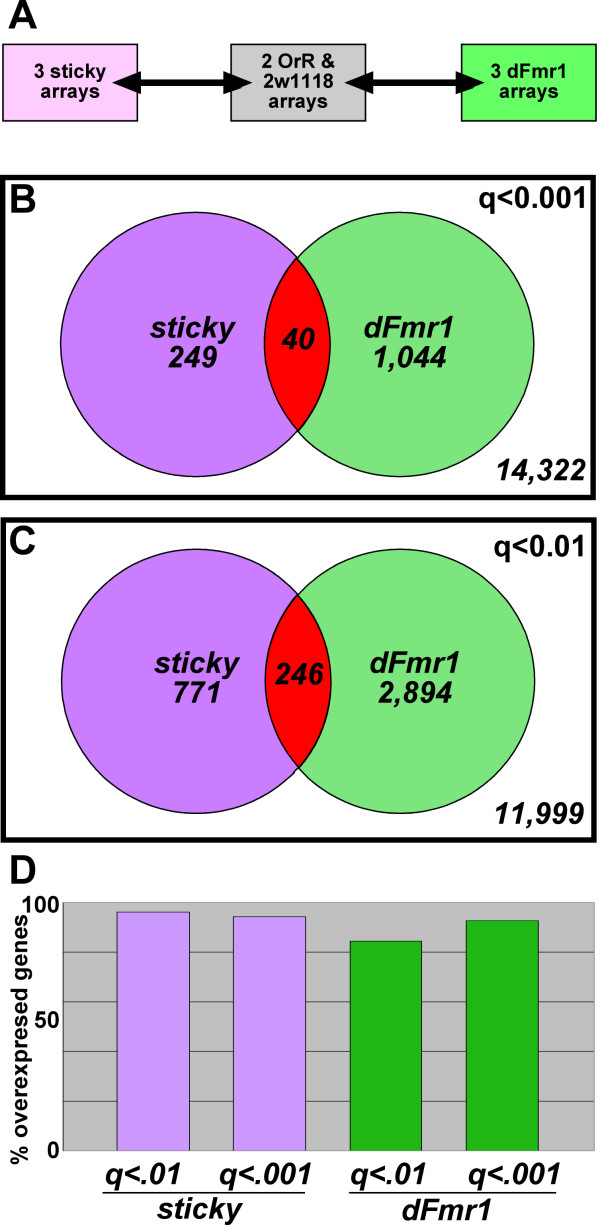
A common set of genes is misexpressed in sticky and dFmr1 mutants. (A) Three biological replicates of sticky total RNA and three biological replicates of dFmr1 mutants were analyzed by NimbleGen gene expression arrays. These data were compared to expression data from two biological replicates of OrR and two biological replicates of w1118 wild-type control RNA. Expression data from the two controls were combined in order to better account for differences in genetic background. (B-C) Venn diagrams showing the number of genes with significantly altered expression levels in sticky and dFmr1 mutants. (B) With a significance threshold of q<.001, we found 249 misexpressed genes and 1,044 misexpressed genes in sticky and dFmr1 mutants, respectively. There were 40 genes differentially expressed in both mutant strains (p = 2.37e-6) and 14,322 genes with no significant change in expression. (C) With a threshold of q<.01, we found 771 misexpressed genes and 2,894 misexpressed genes in sticky and dFmr1 mutants, respectively. There were 246 genes differentially expressed in both mutants (p = 4.27e-14) and 11,999 genes with no significant change in expression. (D) Of the genes that were misexpressed in either mutant the vast majority of them were overexpressed.